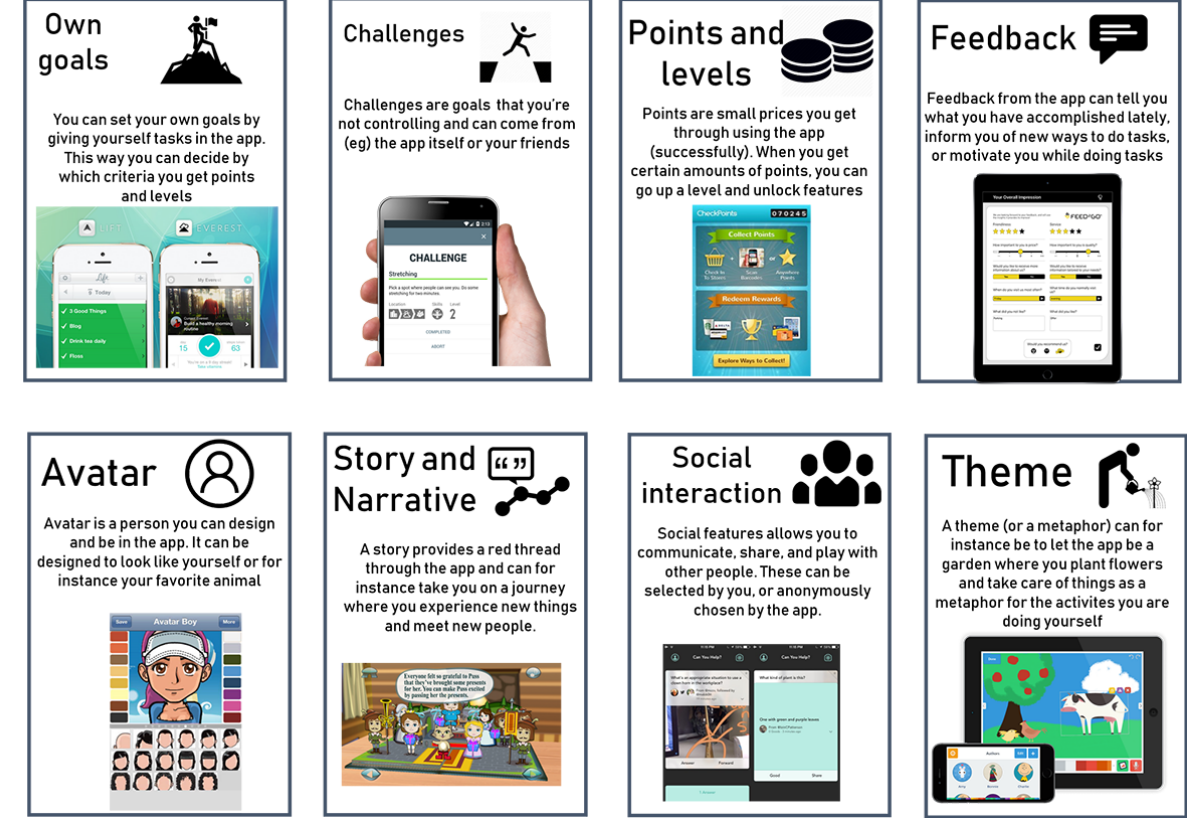
Figure 1. Presentation of game elements from